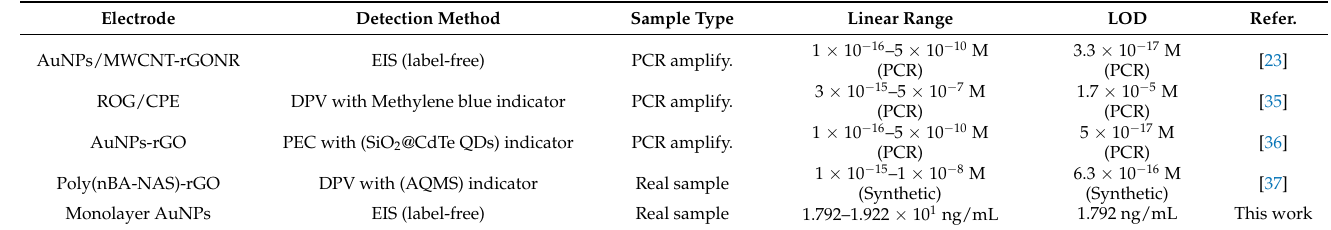
Table 2. Performance comparison of recently developed GMS detection